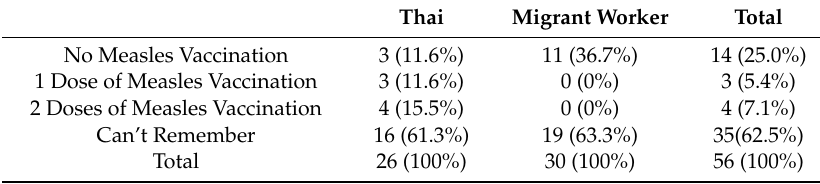
Table 3. Proportion of measles vaccination among Thai compared to migrant worker measles cases ( n = 56).